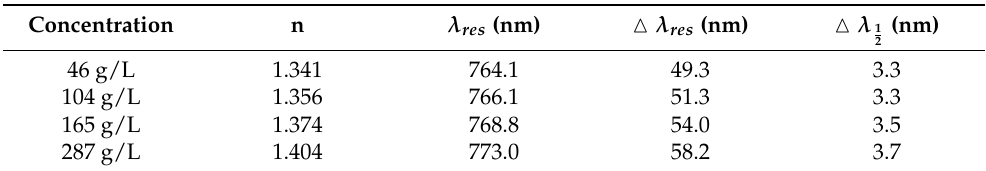
Figure 5. Effect of defect layer thickness on resonant dip position. Table 1. Variation of resonant dip position, wavelength shift and spectral half width with various hemoglobin concentrations.